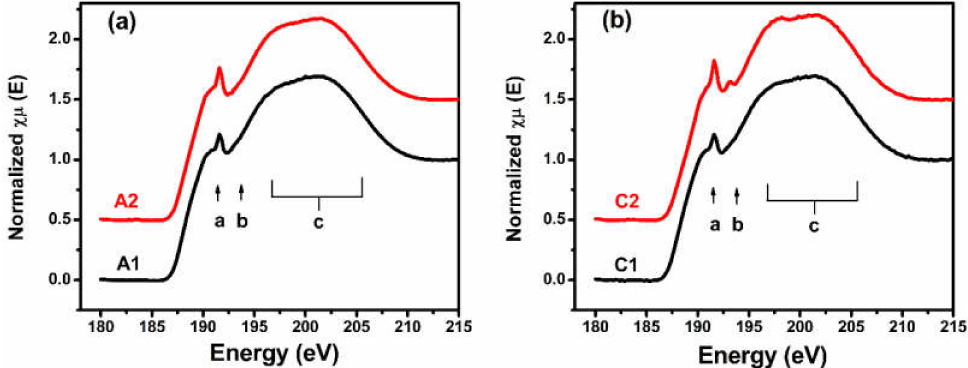
Figure 2. The B K-edge XANES spectra of the B 4 C films (A1 and C1) and B 4 C/Pd layers (A2 and C2) placed in the dry nitrogen environment ( a ) and in the dry oxygen-rich environment ( b ).